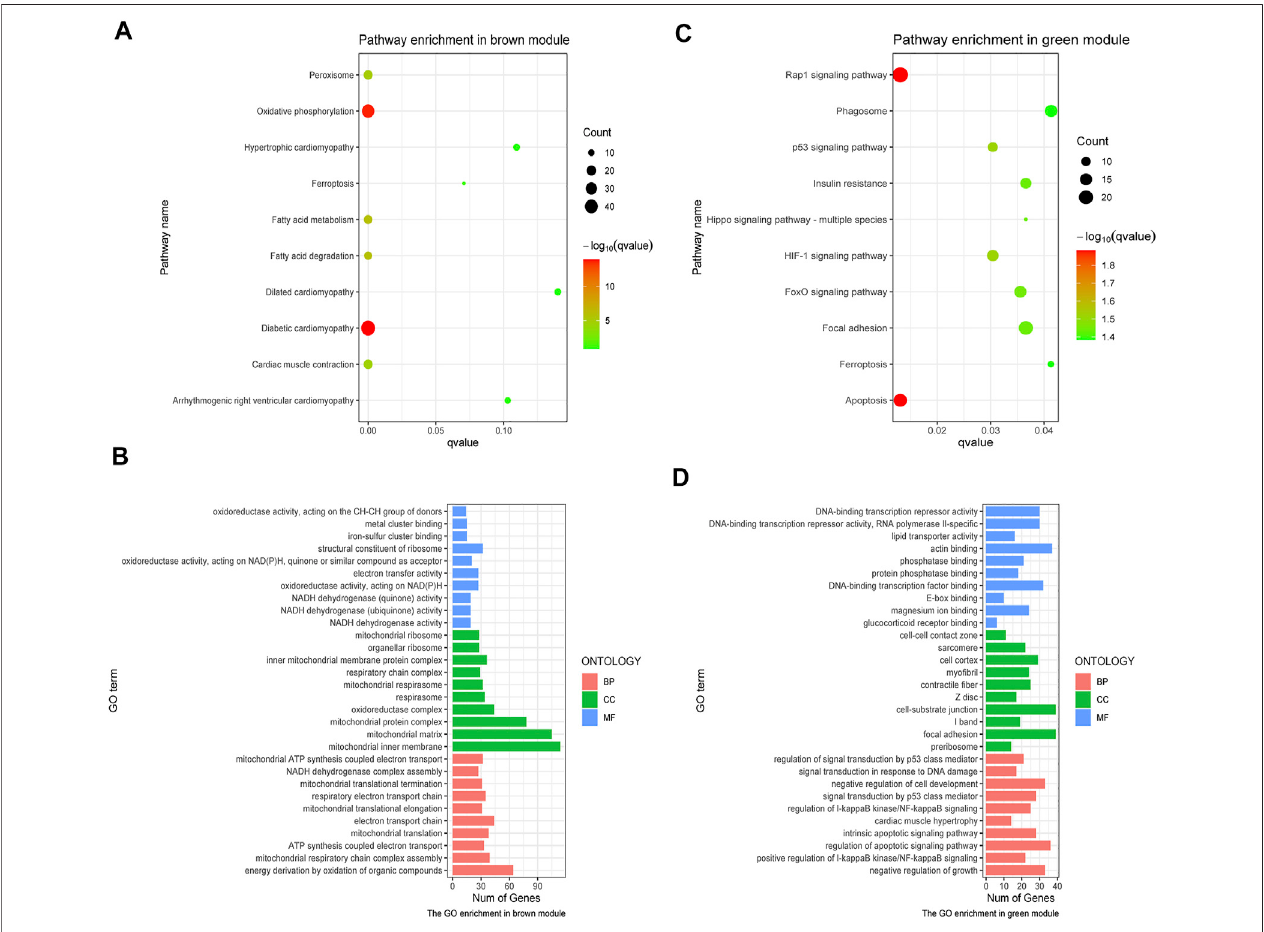
FIGURE 3 | GO and KEGG analysis on crucial modules. (A) KEGG analysis on the brown module. (B) GO analysis on the brown module. (C) KEGG pathway analysisonthegreenmodule. (D) GOanalysisonthegreenmodule.Thesizeofthedotrepresentsthecountnumber,whilethecolormeansthe p -valueofeachpathway.